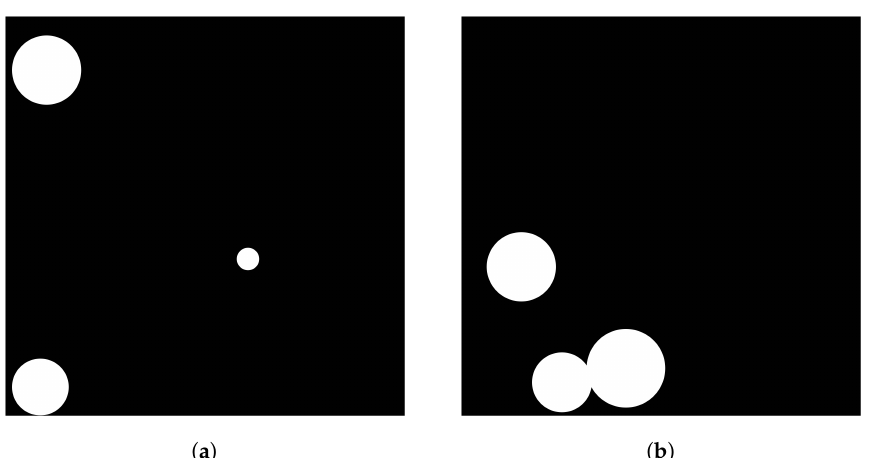
Figure 4. Results from Circular Hough Transform (CHT) on images shown in Figure 1: ( a ) Single crater; ( b ) Multiple